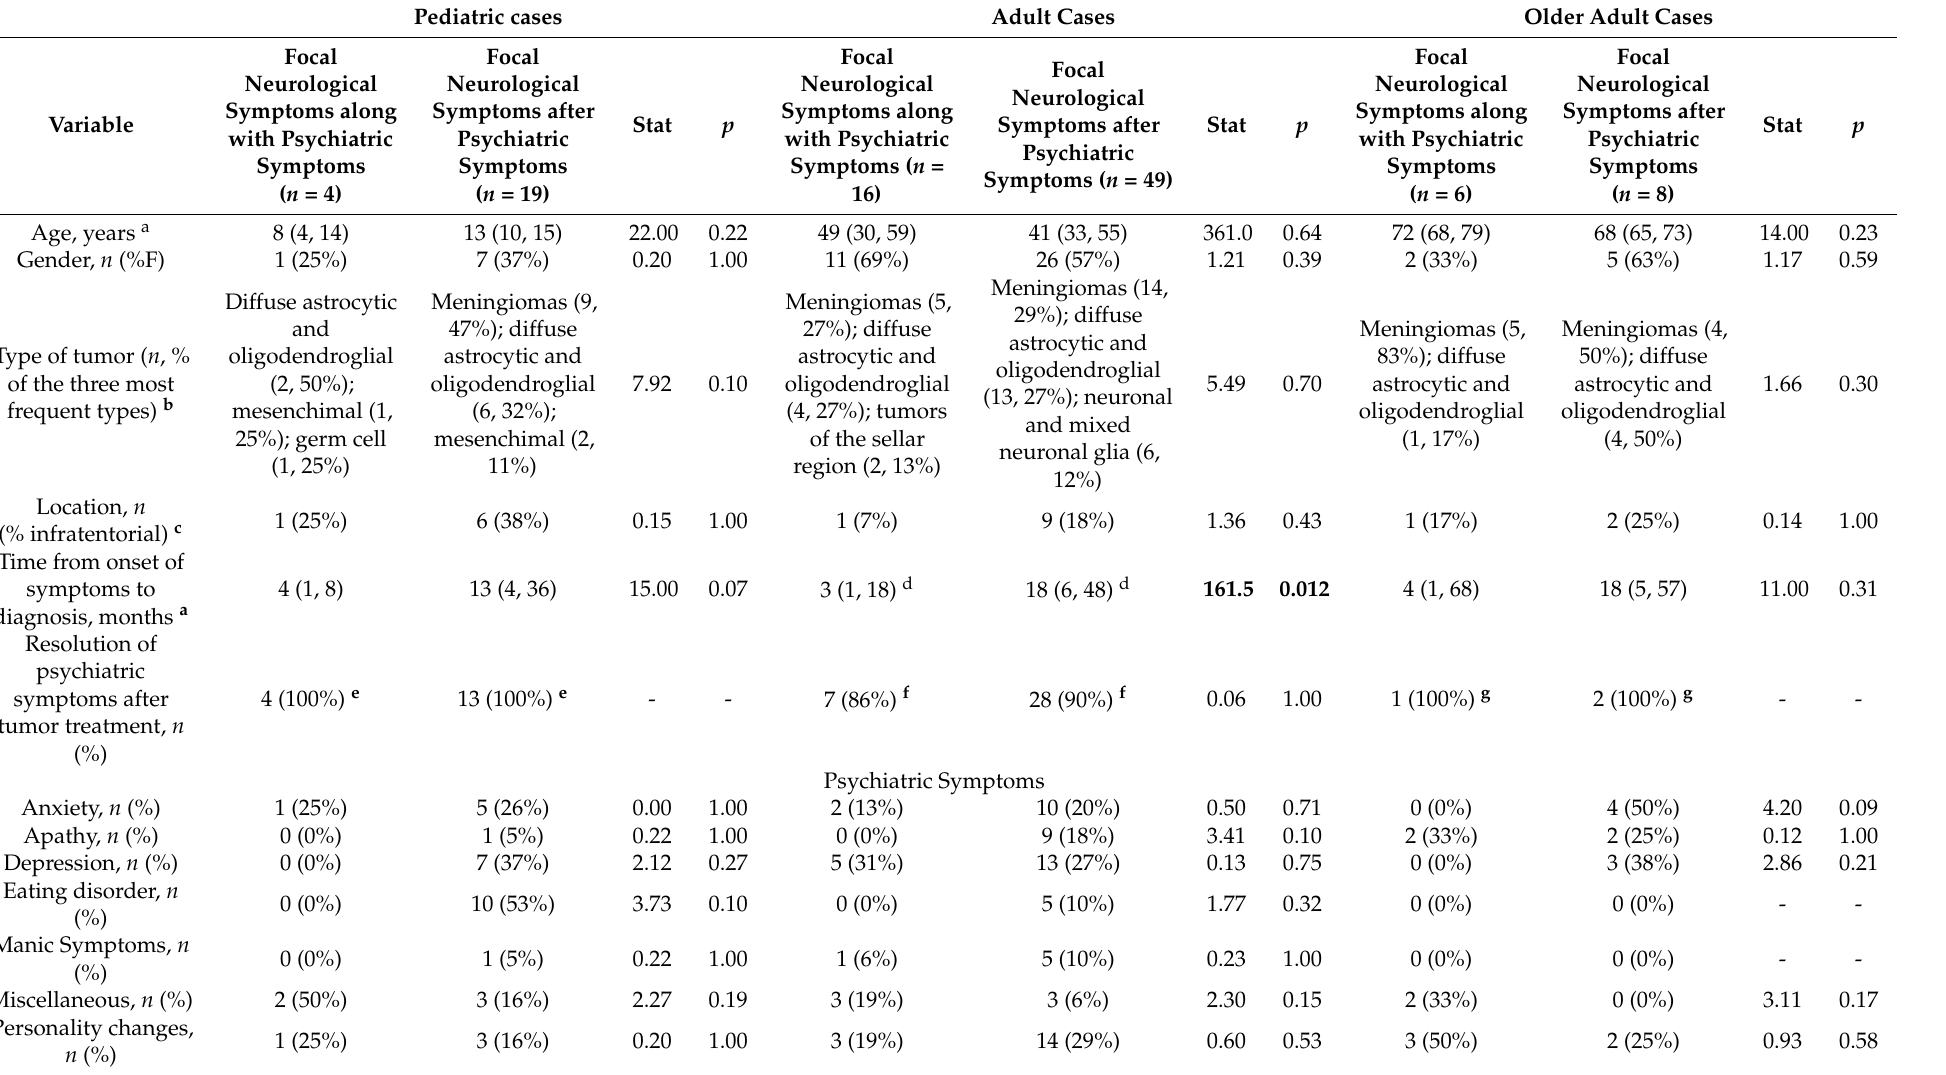
Table 3. Characteristics of cases in which focal neurological symptoms appeared along with or after psychiatric